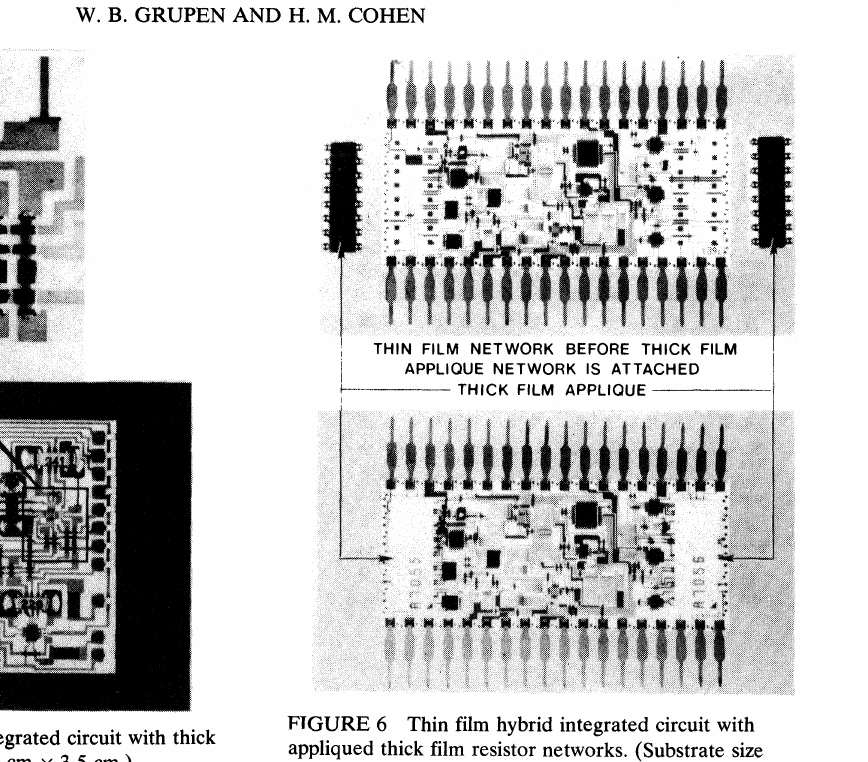
FIGURE 6 Thin film hybrid integrated circuit with appliqued thick film resistor networks. (Substrate size 4.5 cm 2